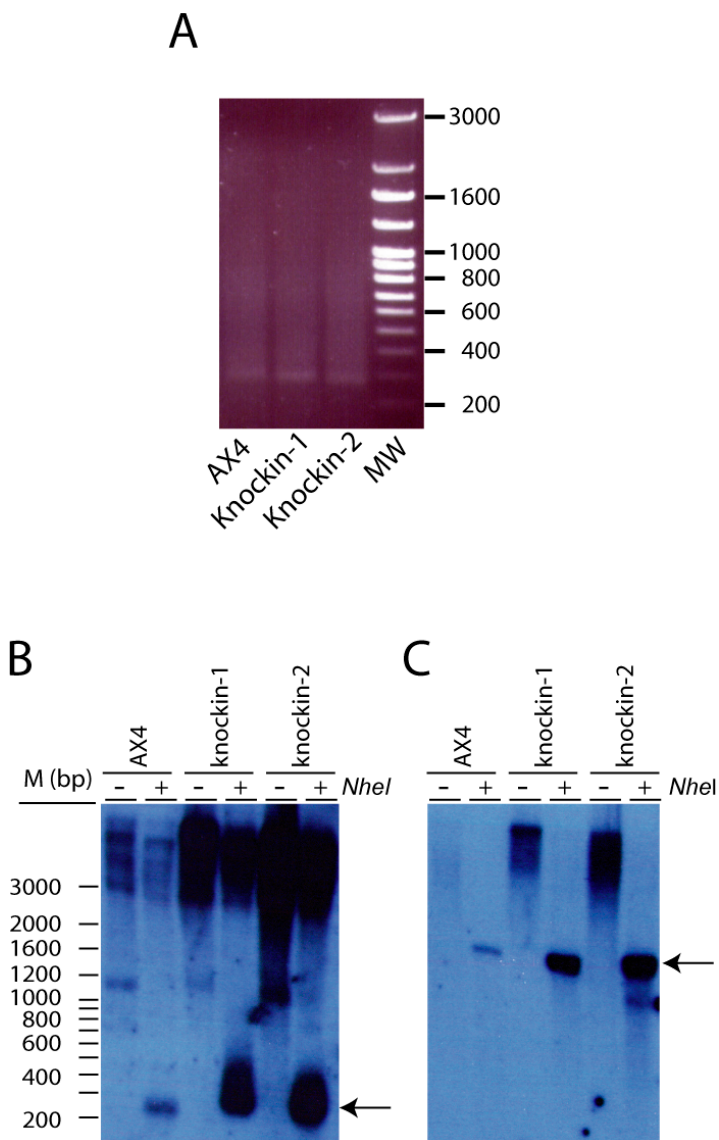
Figure 4. Telomere structure of dyskerin-mutated D. discoideum strains, ( A ) Telomere length was determined by PCR reaction using an oligonucleotide probe complementary to the A(G)n repeats of D. discoideum telomeres and another complementary to the close subtelomeric region. The migration of the amplification products obtained from DNA isolated from the wild-type (AX4) and mutant strains (Knockin-1 and -2) is shown for one experiment representative of the four made with similar results. The MW line shows the migration of the Ladder VII molecular weight marker (Nzytech, Lisbon, Portugal). The size of some of the markers is shown to the right. ( B ) Telomere structure was analyzed by Southern blot of DNAs obtained from AX4, knockin-1 or knockin-2 strains and either non-digested ( − NheI ) or digested with the NheI restriction enzyme (+ NheI ). The panel shows the results obtained after hybridization with a telomere-specific probe. ( C ) The blot shown in panel B was washed and hybridized with a probe complementary to the 26S rRNA. Arrows indicate specific hybridization bands obtained after NheI digestion. The migration of Ladder VII molecular weight marker (Nzytech, Lisbon, Portugal) is shown to the left of panels B and C.